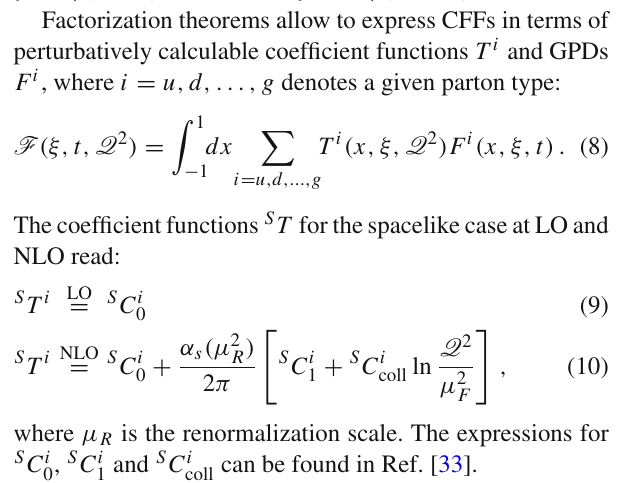
Fig. 1 Imaginary (up) and real (down) part of DVCS CFF ξ S H (ξ) for Q 2 = 2 GeV 2 and t = − 0 . 3 GeV 2 as a function of ξ . The shaded gray bands correspond to the global fit of DVCS data presented in [16] and they show 68% confidence level for the uncertainties of presented quantities. The dashed (solid) lines correspond to the GK GPD model [34–36] evaluated with LO (NLO) DVCS coefficient functions